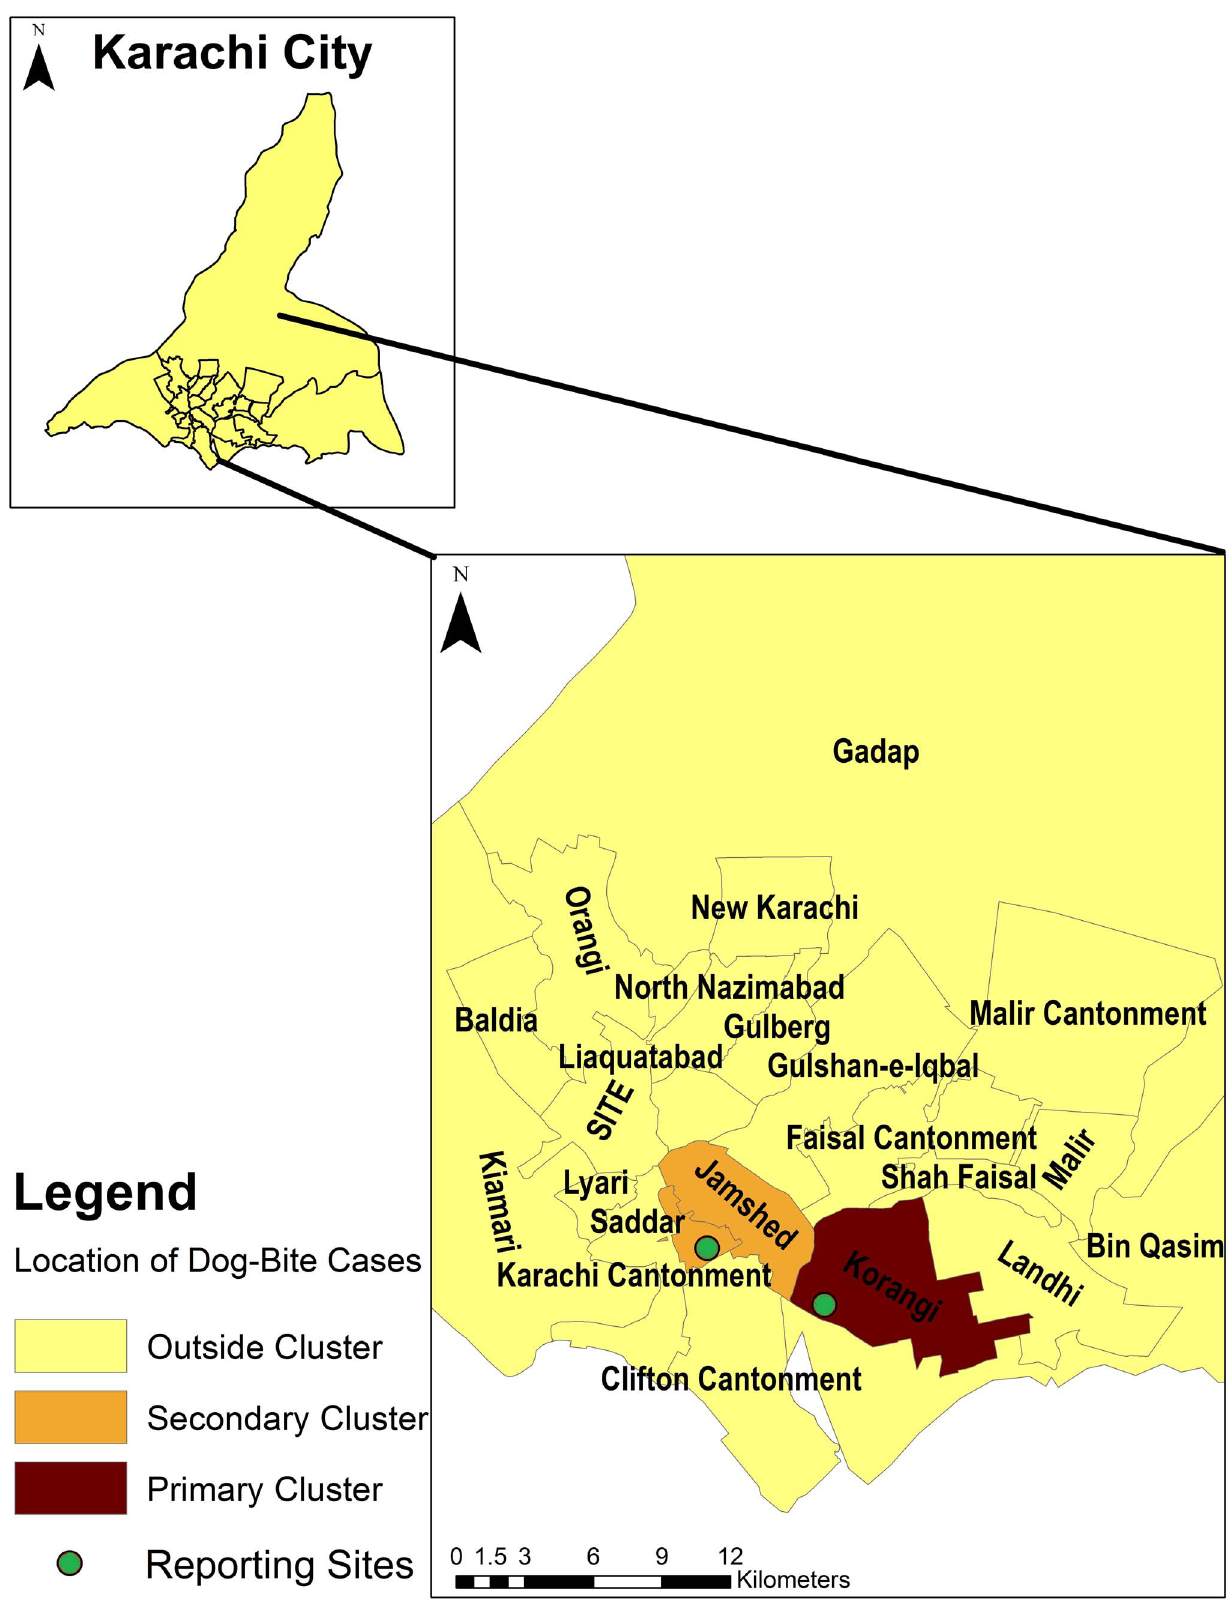
Figure 5. Cluster analysis of dog-bites cases by administrative towns in Karachi, Pakistan.